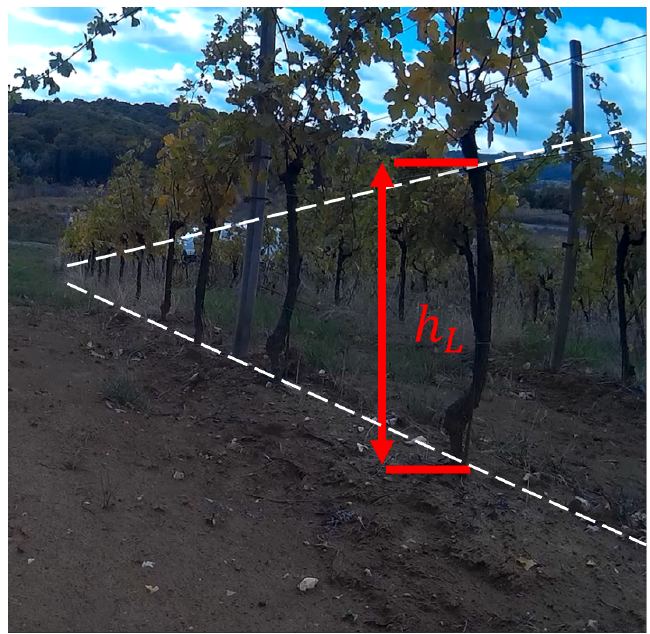
Figure 8. Height assumption to locate a vine trunk near the ATMM-VIV. Assuming the actual height of the identified feature in the image allows localization of the position of the observed object, relative to the